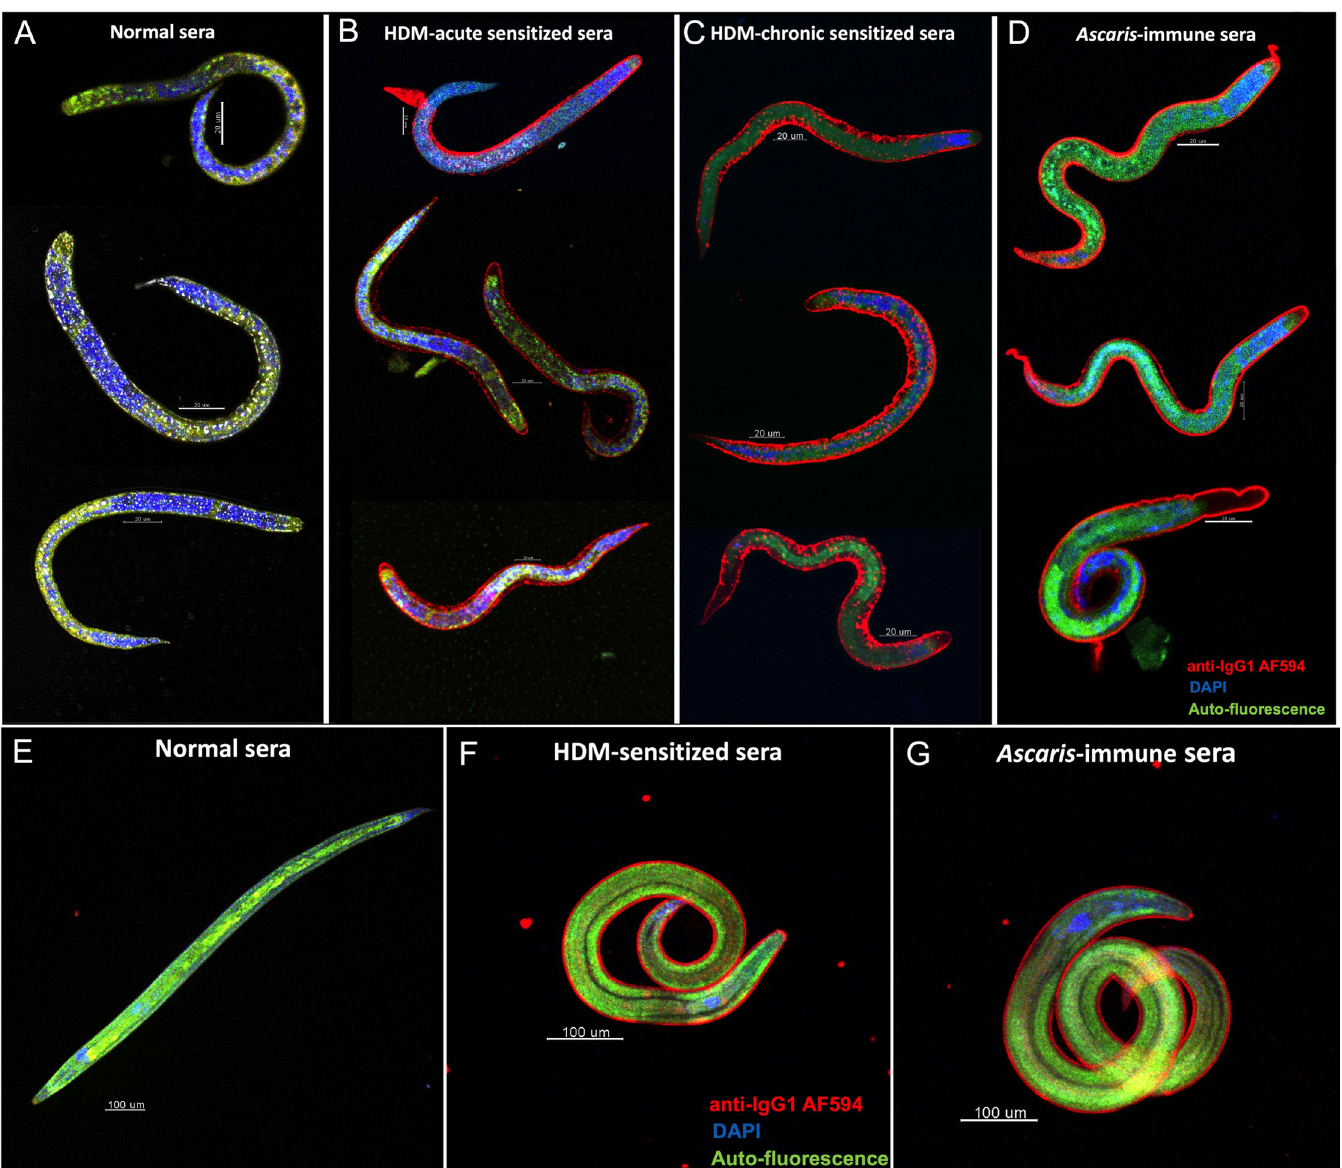
Fig 2. HDM-driven antibodies recognize antigens in the surface of early Ascaris migrating larval-stages. Representative confocal microscopy images highlighting the HDM-specific IgG1 (red) with the infective L3 larvae (A-D) and lung-stage larvae (E-G) using sera from na ï ve mice (A and E), HDM-sensitized mice (B, C and F), and Ascaris -immune sera (D and G). Nuclear staining with DAPI (blue) and autofluorescence (green) is also